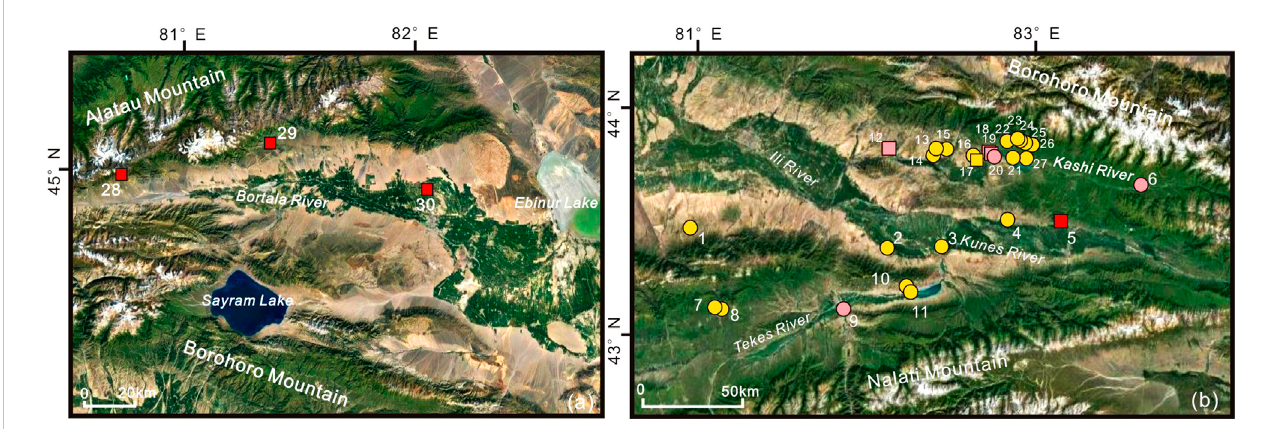
FIGURE 4 Topographic map of Western Tianshan Mountains and the sites mentioned in this study. (A) Bortala River Basin. 28. Adonqolu; 29. Husta; 30. Quanshuigou. (B) Ili River Basin. 1. Suodunbulake; 2. Fanliuyilegedai; 3. Shankoushuiku in Gongliu County; 4. Tiemulike; 5. Ayousaigoukou; 6. Tangbalesayi; 7. Biesikalagai; 8. Saerhuobu; 9. Koksu West Cemetery No.2; 10. Plot XV and Plot X, Area A, Qiafuqihai; 11. Yeshikelieke site A; 12. Kalasu; 13. Shibukeqi No.1 14. Shibukeqi No.2; 15. Taerketebei; 16. Dongmaili; 17. Qiongkeke; 18. Qialegeer; 19. Jirentaigoukou; 20. Wutulan; 21 – 26. Jialekesikayinte; 27.